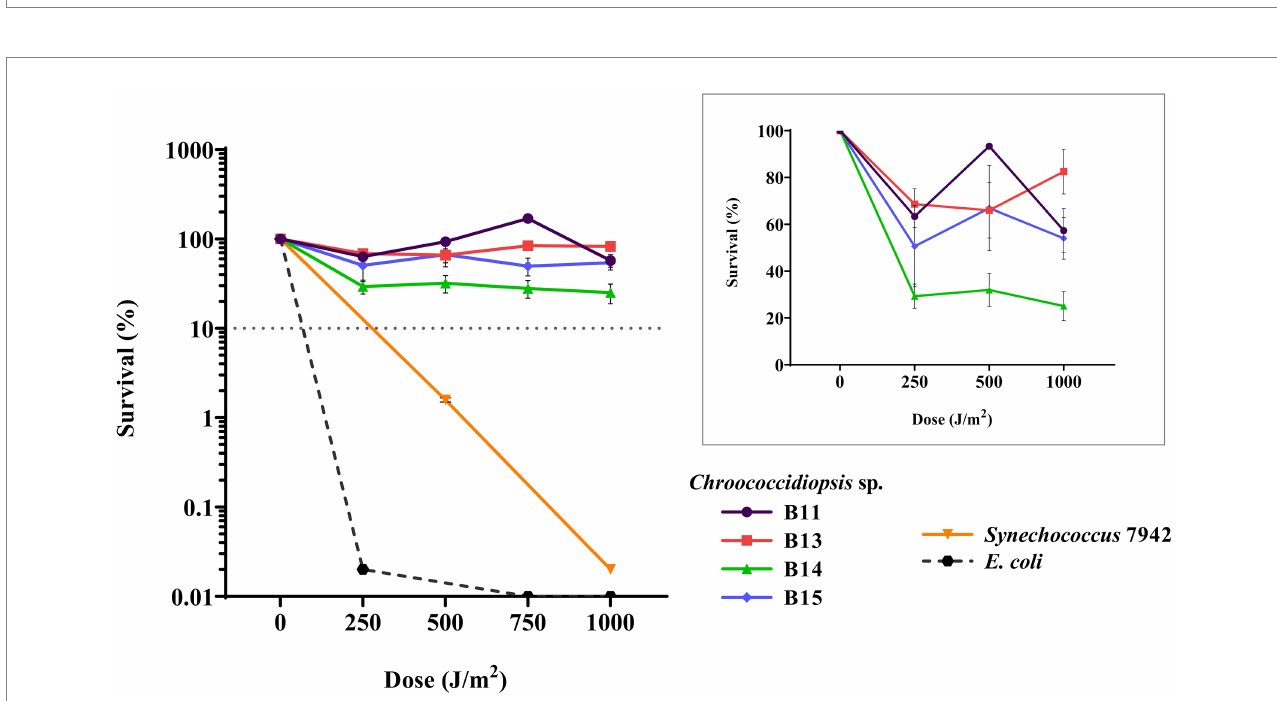
FIGURE 7 Viability of cyanobacterial cultures after exposure to UV-C radiation. The graph shows the averages of three biological replicates together with the standard deviation. The smaller graph shows the survival percentage just for Chroococcodiopsis sp.